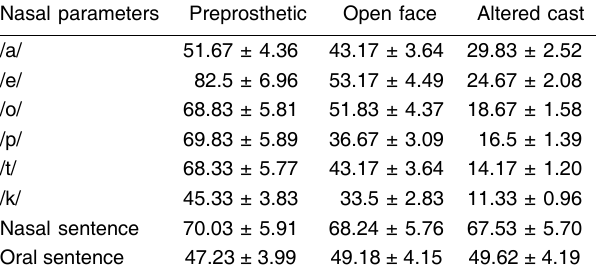
Table 3 Comparison of the mean values of the degree of nasality in the vowels /a/,/e/,/o/,/p/,/t/,/k/ nasal sentence and oral sentence between the preprosthetic phase, the open face impression technique, and the altered cast impression technique